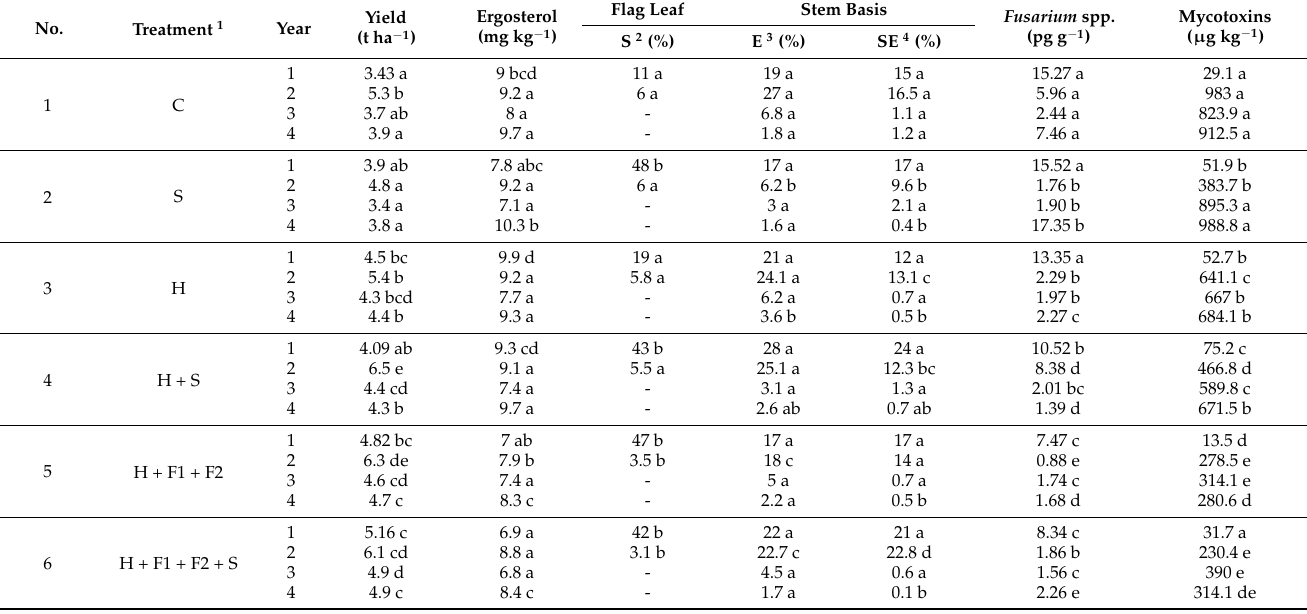
Table 2. Quantitative and qualitative parameters of spring wheat grain under diverse chemi- cal/biostimulator treatments (disease severity: low <20%, moderate 20–40%, and high >40%). The same letter in the particular year of the study indicates that the value is not significantly different ( p ≥